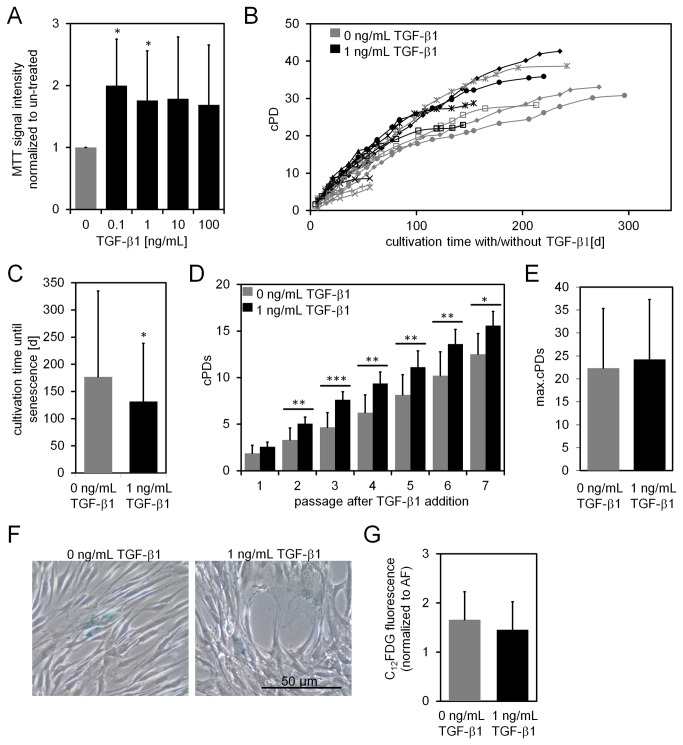
Influence of TGF-β1 on short- and long-term expansion and senescence.MSCs were stimulated for 7 days with increasing concentrations of TGF-β1 and proliferation was estimated using the MTT assay (A; n = 5). MSCs were cultured with or without 1 ng/mL TGF-β1 until they stopped proliferation. Cumulative population doublings (cPDs) were calculated throughout culture expansion and depicted by symbols for each passage (B; n = 6). The average culture period until proliferation arrest is shorter if cells are continuously cultured with TGF-β1 (C; n = 6). Comparison of cPDs for the first seven passages for TGF-β1 treated and un-treated MSC revealed a proliferative advantage particularly in the initial three passages (D; n = 6). The maximal cPDs at the time of ultimate proliferation arrest were similar with and without TGF-β1 treatment (E; n = 6). SA-β-gal activity was measured in MSCs cultured either with or without TGF-β1 for 7 passages by histochemical analysis with X-gal staining (E) or flowcytometric analysis of C12FDG (F; n = 3; *p < 0.05; **p < 0.01).